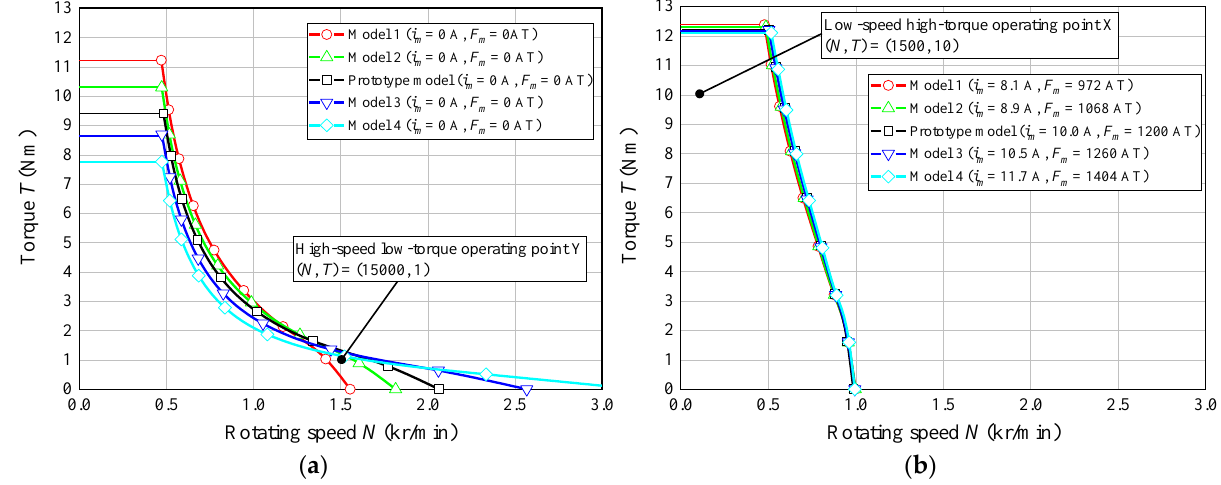
Figure 25. N–T characteristics of proposed motor models: ( a ) without F m ; ( b ) with F m .